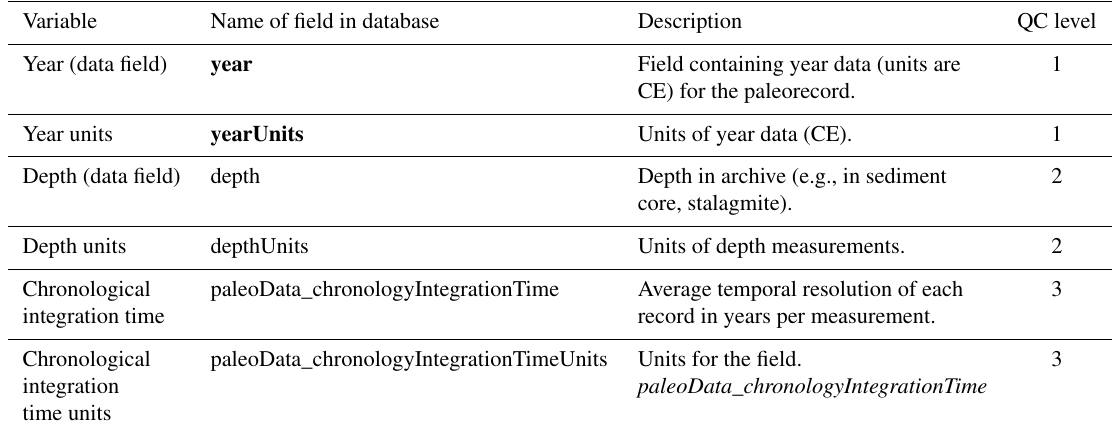
Table 5. Key depth–age metadata. ∗ Bold text indicates Level 1 (required) fields in the